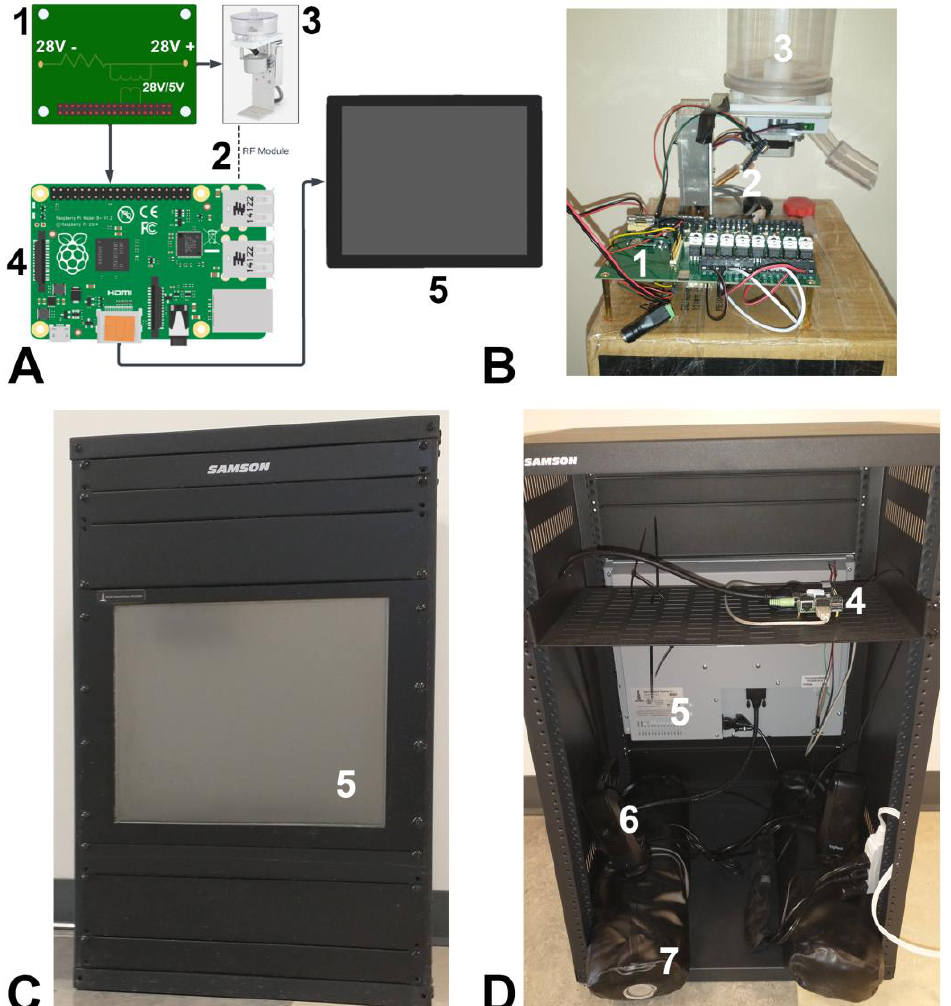
Figure 1. Schematic layout and actual device. ( A ) The conceptual schematic organization of the touchscreen device with pieces numbered in black, corresponding to white numbers on the actual device (panels ( B – D )). A Raspberry Pi controls the touchscreen and records responses. Output is then taken from the Raspberry Pi I/O pins and put through an external printed circuit board to step the voltage up to the 28 V needed for peripheral components. Physical inputs were available but not used in the current studies. ( B ) An image of the remote-controlled dispenser, attached to the PCB. A raspberry Pi is attached underneath the PCB and not visible. Not in this picture is the sonalert tone generator which was also hooked up to the PCB. ( C ) Front of testing device showing screen. ( D ) Rear of testing device showing back of screen, Pi, and other components. Numbered items indicate: (1) PCB, (2) RF transceiver, (3) pellet dispenser, (4) Raspberry Pi, (5) touchscreen, (6) audio speakers, (7) weighted